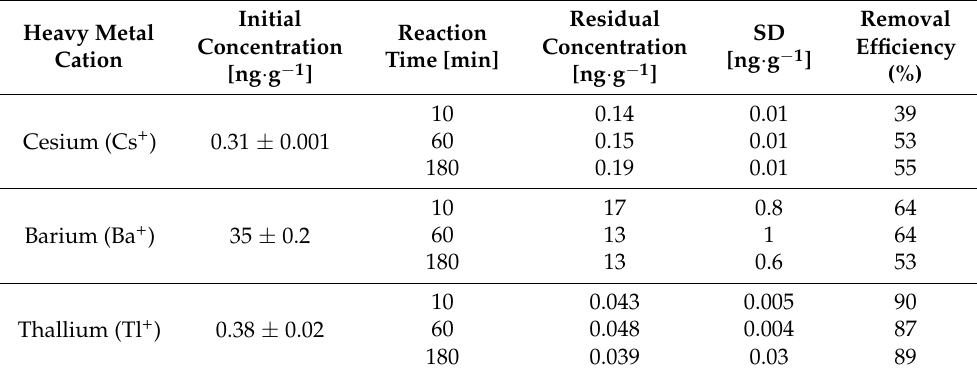
Table 13. Adsorption kinetics of different heavy metal cations for NPCT1 in non-contaminated non-carbonated mineral water.